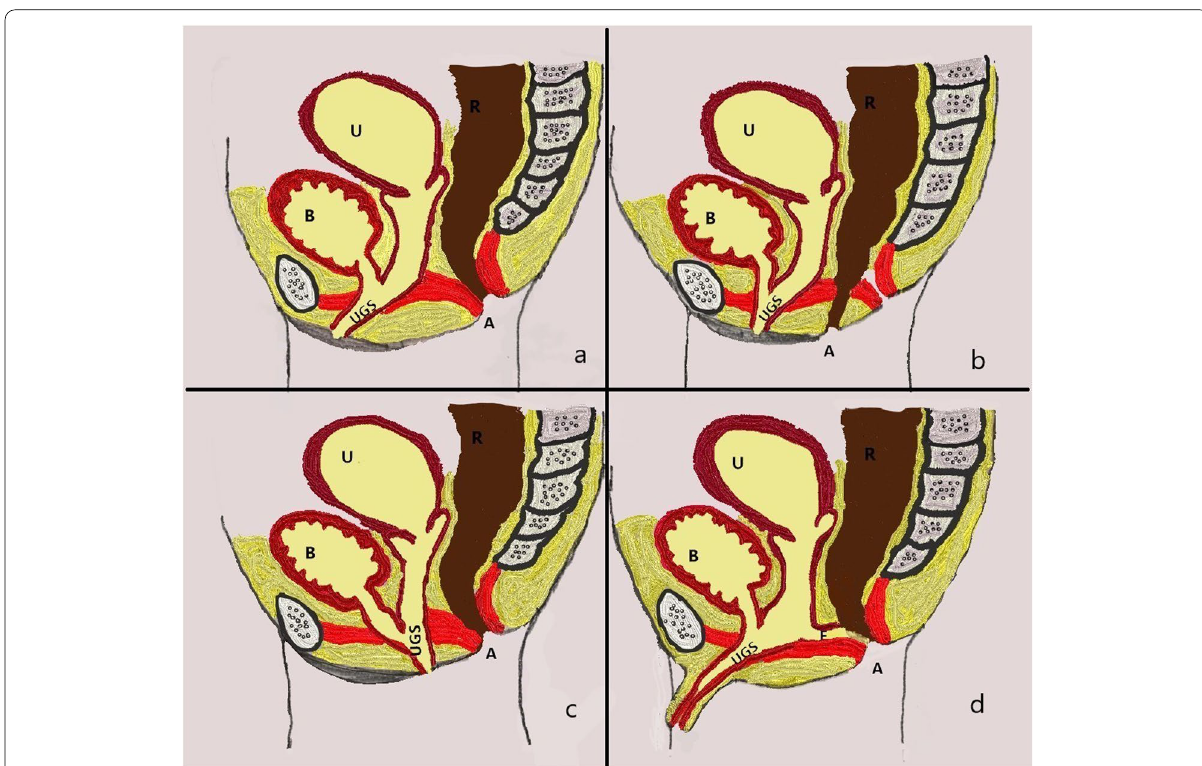
Fig. 3 a Persitant urogenital sinus. b The cloacal variant. c Posterior cloacal variant. d Persistant urogenital sinus with recto-vaginal fistula ( A , anus; R , rectum; U , uterus; B , bladder; F , fistula; UGS , urogenital